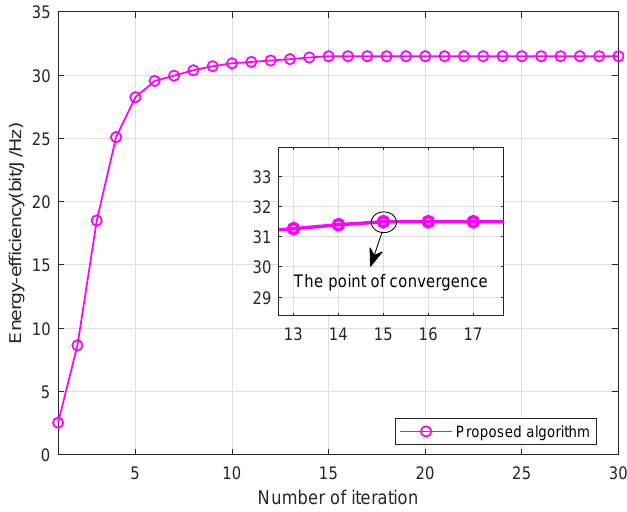
Figure 1. EE (energy efficiency) versus iterative with P t = 30 dBm, α = 2, U =